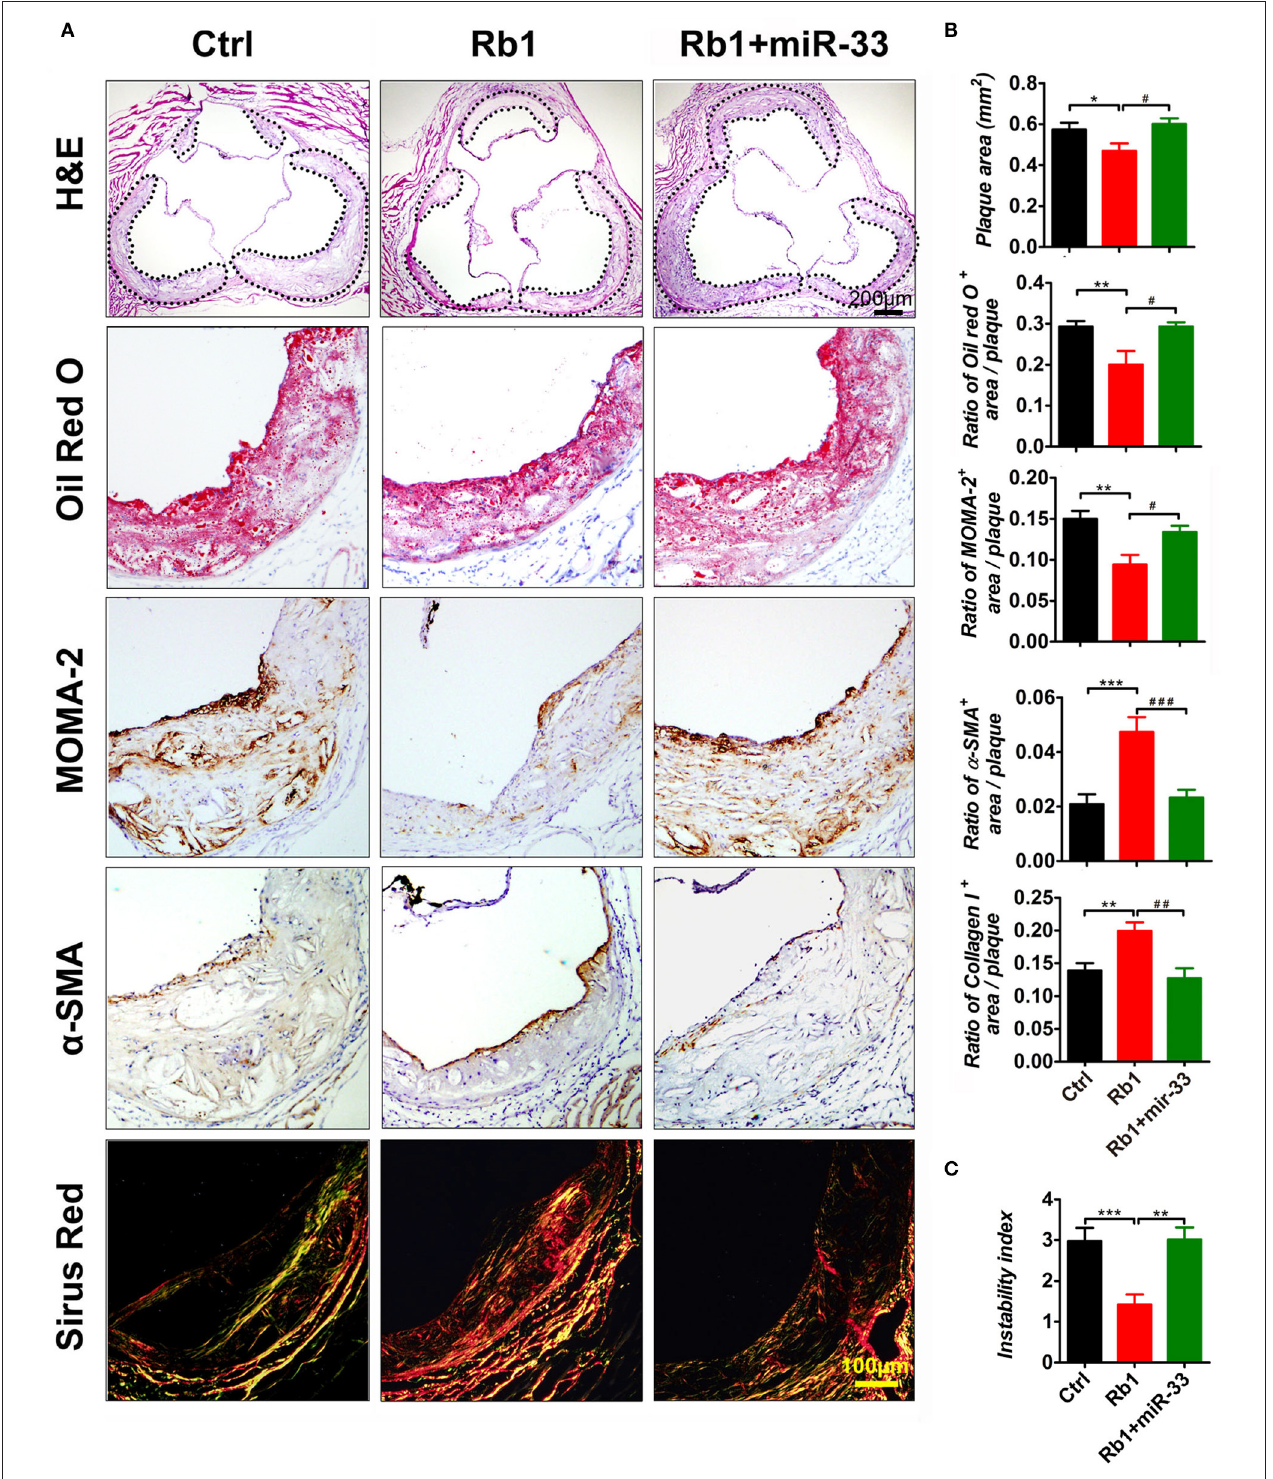
FIGURE 2 | Rb 1 attenuated atherosclerotic plaque growth and enhanced plaque stability in apoE − / − mice. (A) Histological analysis of cross sectional aorta roots from three groups by staining with H&E, Oil Red O, anti-MOMA-2, anti- α -SMA, or Sirus Red. Dashed lines encircle atherosclerotic plaques ( n = 14 ∼ 15/group). (B) Quantification of the plaque area vs. the total cross sectional area of aorta root. Quantification of the ratio of Oil Red O positive area, MOMA-2 positive area, α -SMA positive area or the collagen I positive area vs. the total plaque area ( n = 14 ∼ 15/group). (C) Average values ( + SEM) of atherosclerotic plaque instability index, which was calculated according to the formula: (oil red O + area plus MOMA-2 + area)/(a-SMA + area plus collagen I + area) ( n = 14 ∼ 15/group). * p < 0.05; ** p < 0.01; *** p < 0.001; # p < 0.05; ## p < 0.01; ### p < 0.001, one-way ANOVA.